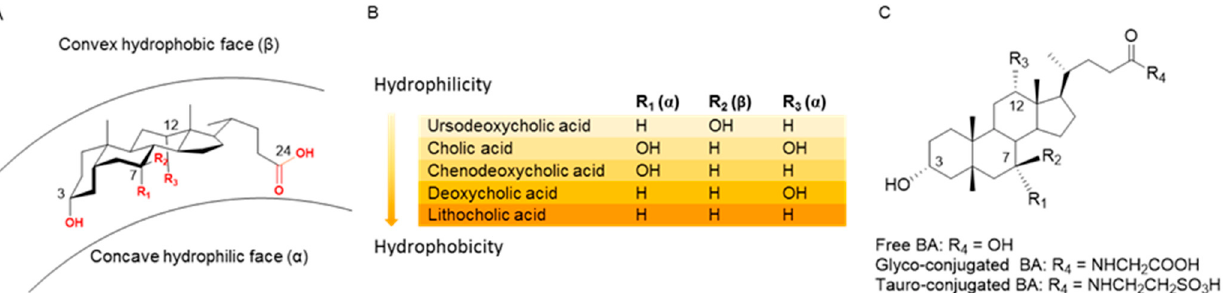
Table 1. Summary of BA hybrids. Hybrid